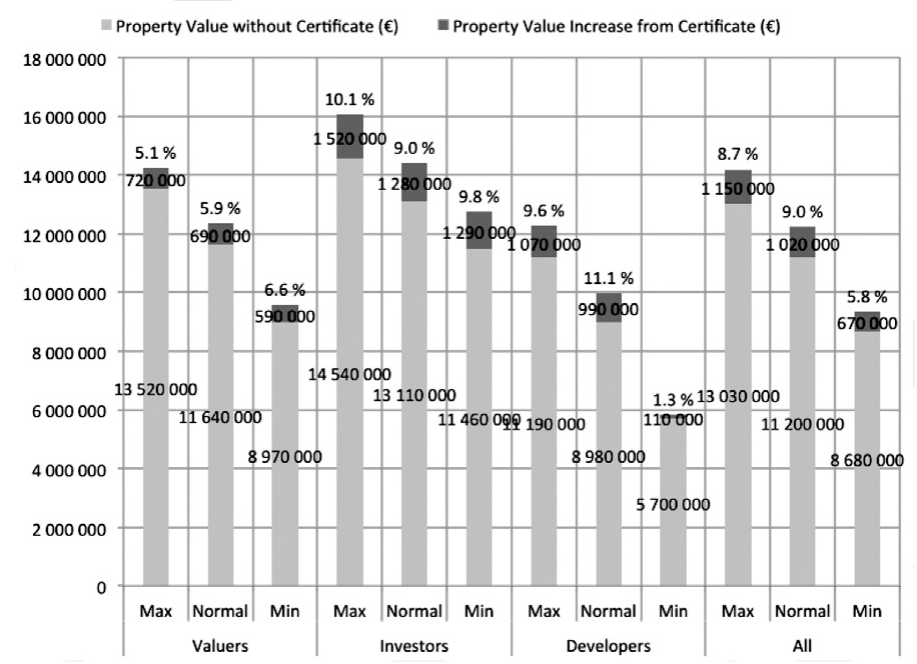
Fig. 2. Property value means with and without